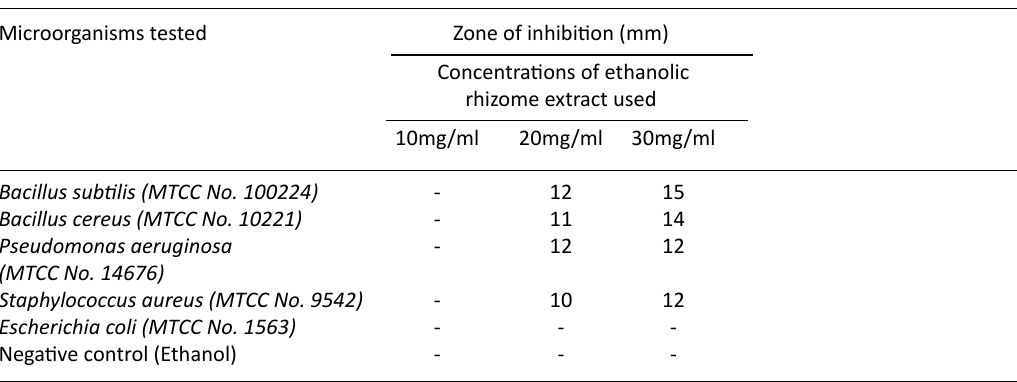
Table 3. Antibacterial activity from rhizome extract of Coleus forskohlii Microorganisms tested Zone of inhibition (mm)